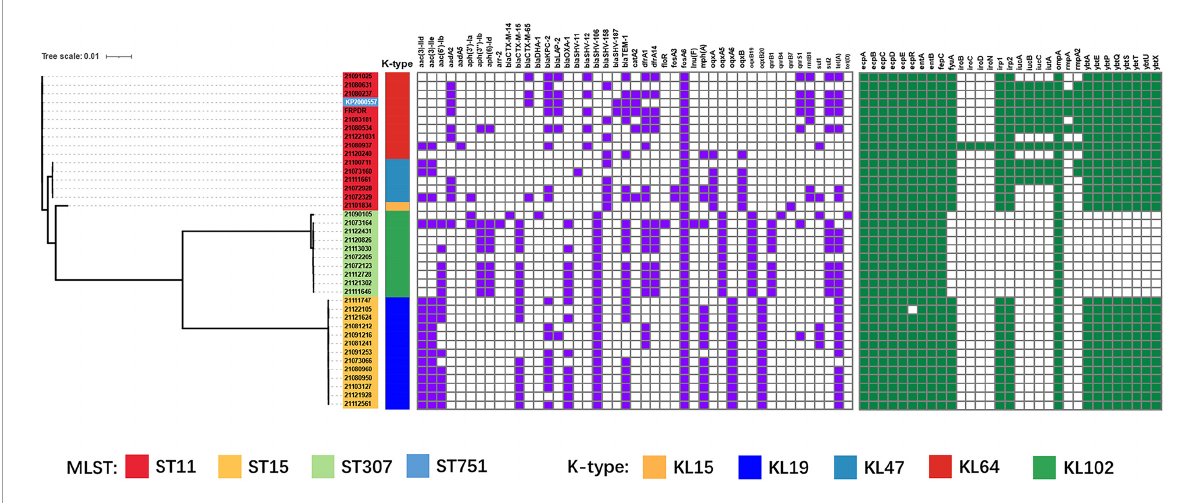
FIGURE3 Phylogenetic tree based on core genome single nucleotide polymorphisms (SNPs) and distribution of resistance genes, virulence factors of K. pneumoniae isolates (ST11, ST15, ST307). Isolates with different MLST and capsule types are shown in different colors using iTOL v4 (Letunic and Bork, 2019). Carrying resistance genes are colored in purple, and carrying virulence factors are colored in green. Scale bar indicates the number of nucleotide substitutions per